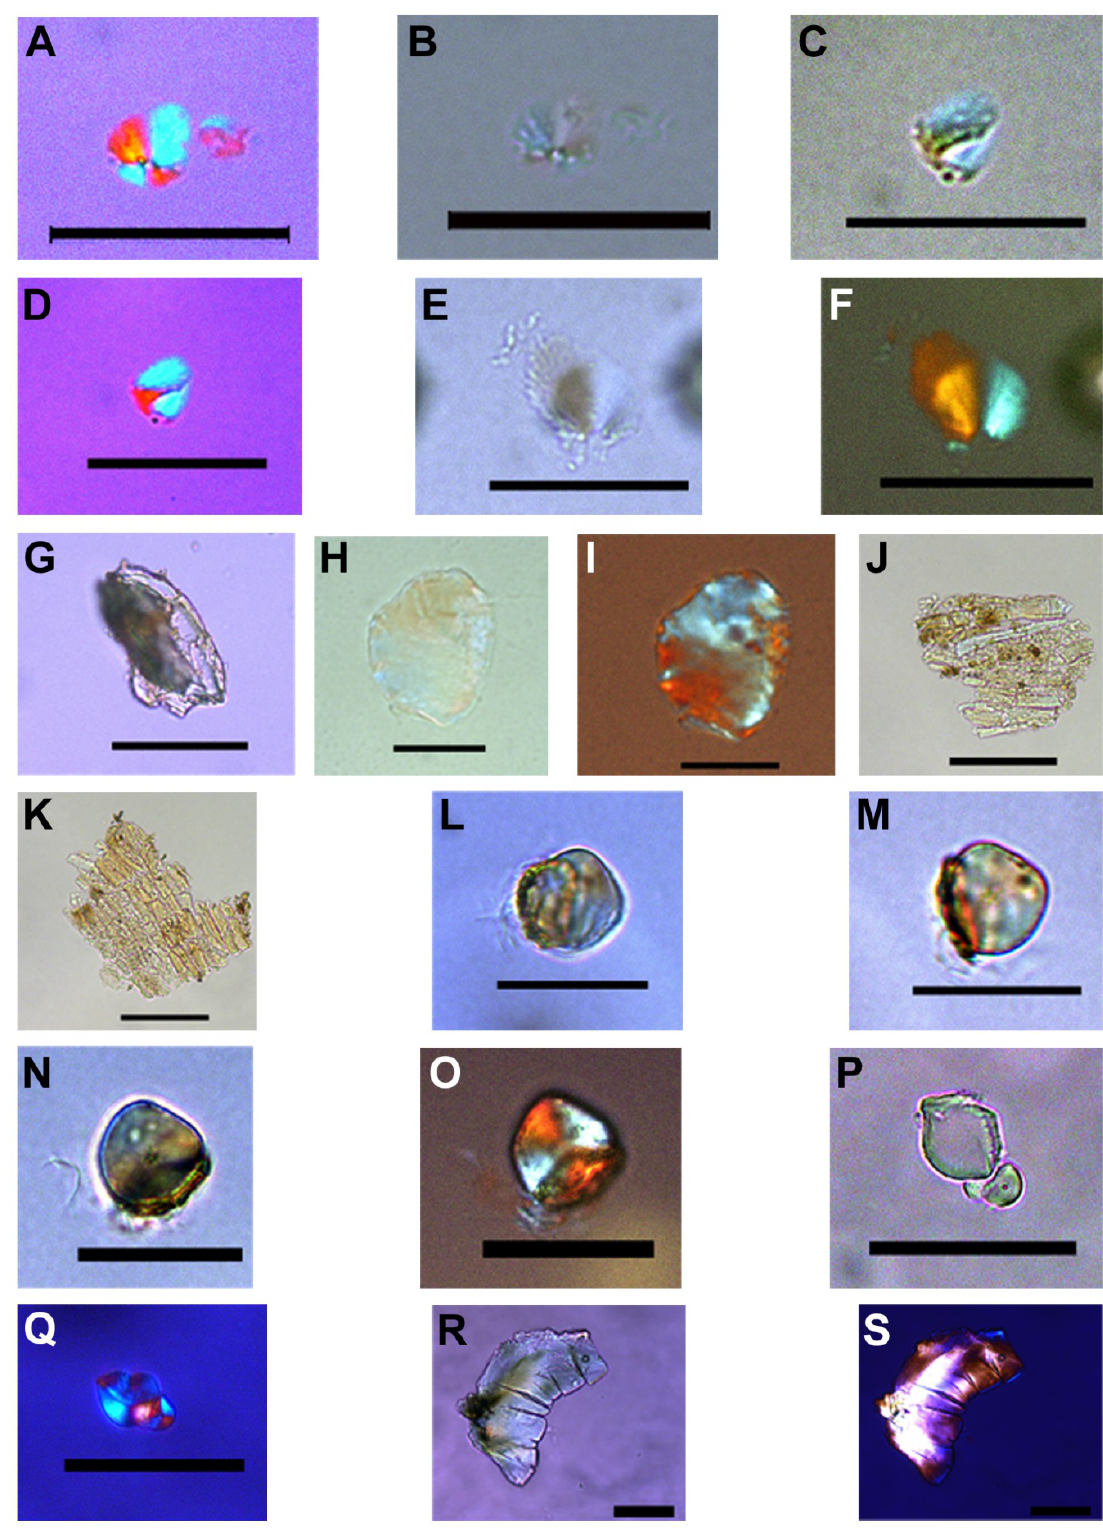
Figure 16. Starch grains and various elements recovered from sediment I (A-K) and sediment II (L-S) on the left side of the artifact. A-D: Non-identified elements recovered from sediment I; A-B: Non-identified element 1; C- D: Non-identified element 2; E-F: Non-identified element 3; G: Non-identified element 4; H-I: Non identified element 5. J-K: Cellular tissue, possibly radial parenchyma. L-Q: Starch grains recovered from sediment II; L-O: Starch grain 1; P-Q: Starch grain 2. R-S: Non-identified element recovered from sediment II. Photos taken under bright field (B, C, E, G, H, J, K, L, M, N, P, R) and polarized (A, D, F, I, O, Q, S) light. Scale bar: A-F, H-I, L- O, 20 µm; G, J-K, P-S, 50 µm. Photos by Rodrigo Angeles